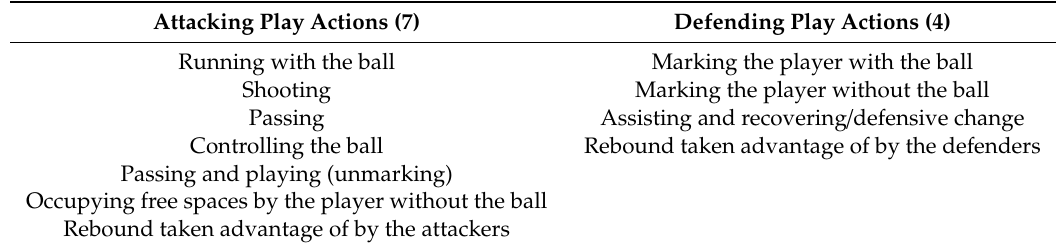
Table 2. Play actions in the Instrument for the Measurement of Learning and Performance in Football (IMLPFoot).